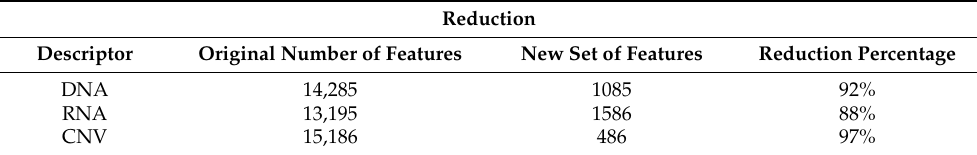
Table 10. Shapes of produced